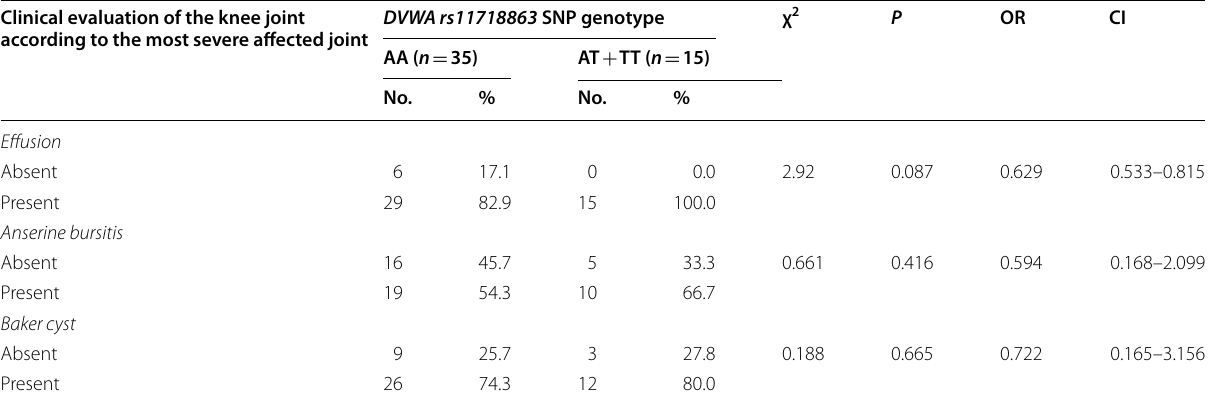
CI confidence interval, DVWA double Von Willebrand factor domain A, OR odds ratio, P P value for comparison between AA and AT polymorphism, χ 2 value of chi-square test, % percentage of patients *Statistically significant at P ≤